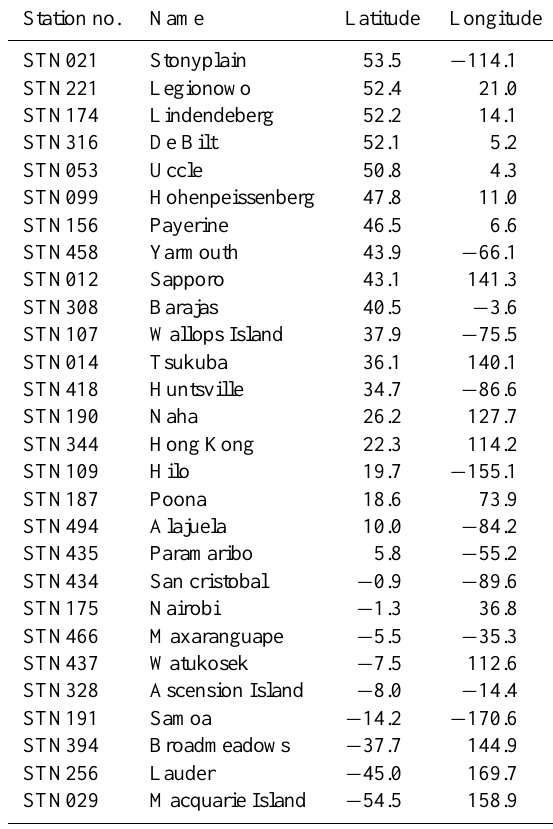
Table 3. List of ozonesonde stations used for the validation. Station